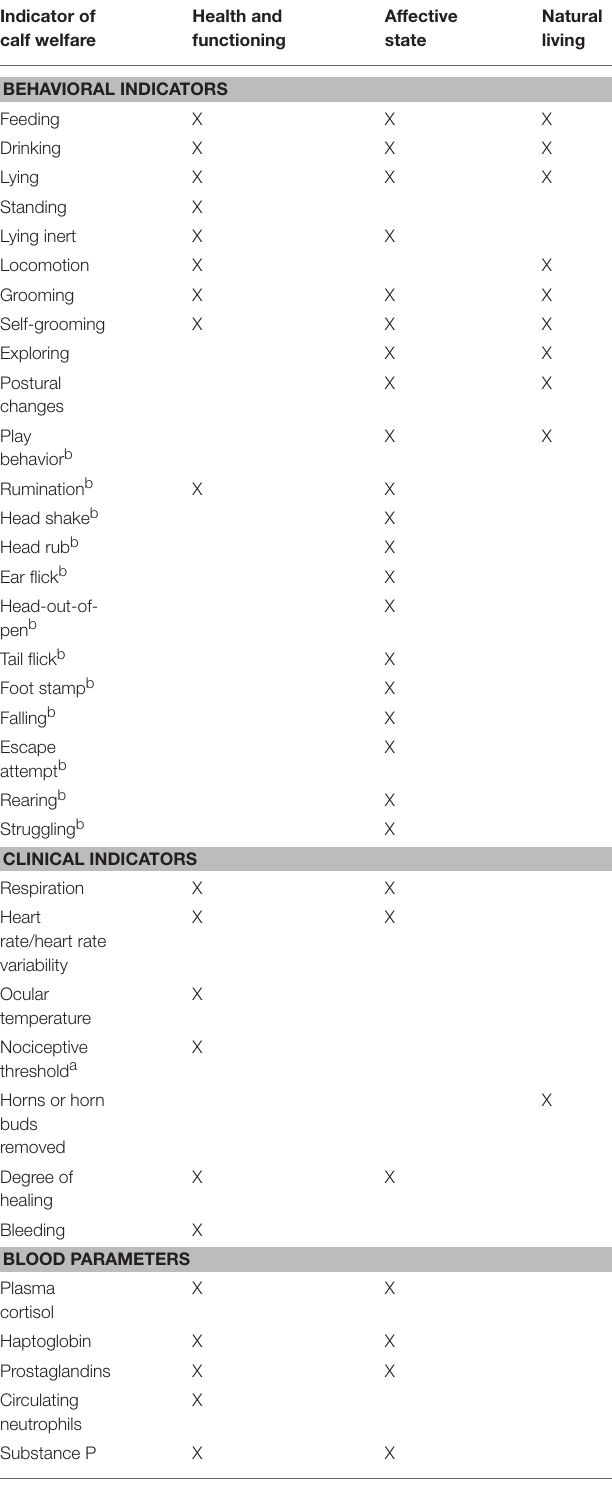
TABLE 1 | Schematic overview of the categorization of the five (not mutually exclusive) categories of welfare indicators mentioned in this review as well as their relevance for the three major welfare concerns: health and functioning, affective state, and natural living (14). Indicator of calf